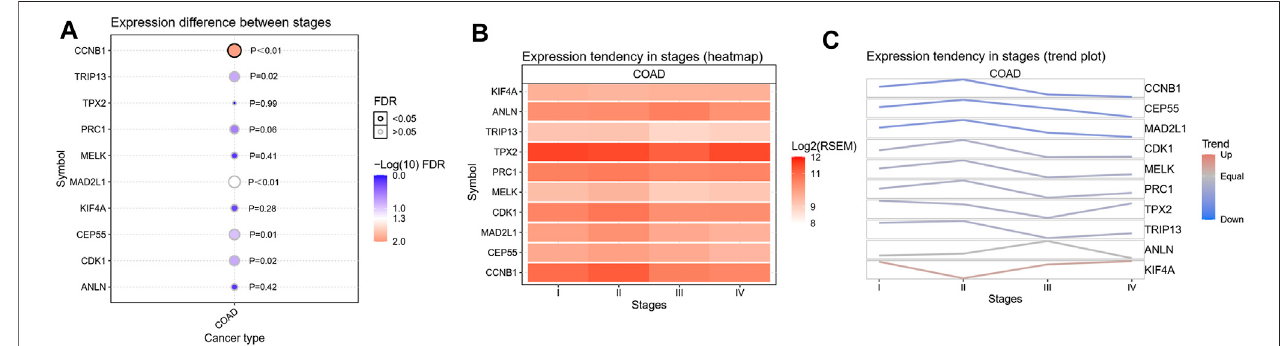
FIGURE4| Thecorrelationanalysisofthe10hubgenes ’ expression andCRCclinicstages. (A) Expressiondifference betweenstages, (B) Expressiontendency in stages (heatmap), (C) Expression tendency in stages (trend